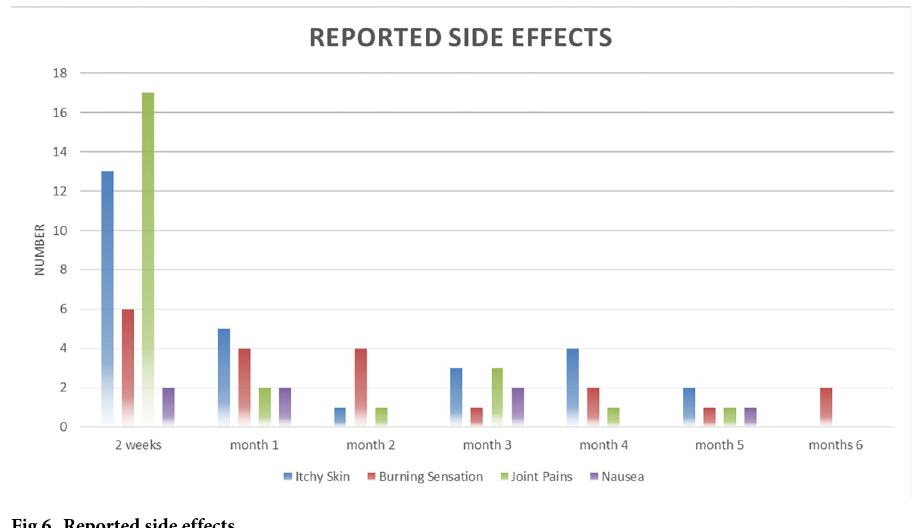
Fig 6. Reported side